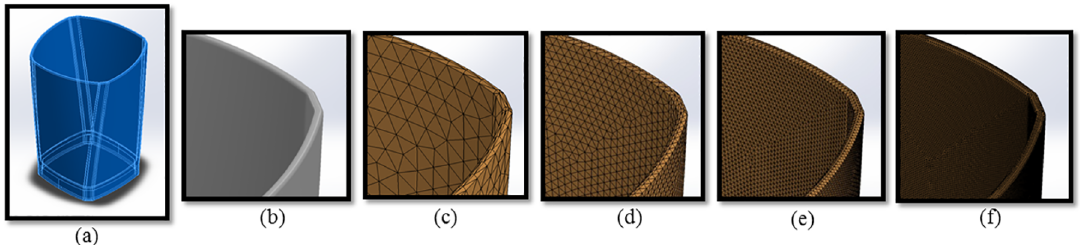
Figure 5. Details of the simulation domain and mesh (triangular elements): a) shell domain; b) details of the domain boundaries and corners; c) mesh element of 5.0 mm; d) mesh element of 2.0 mm; e) mesh element of 1.0 mm; f) mesh element of 0.5